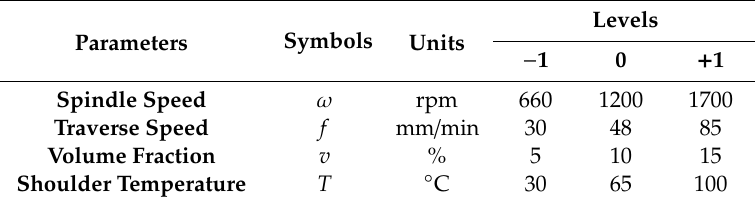
Table 2. Processing parameters and their respective